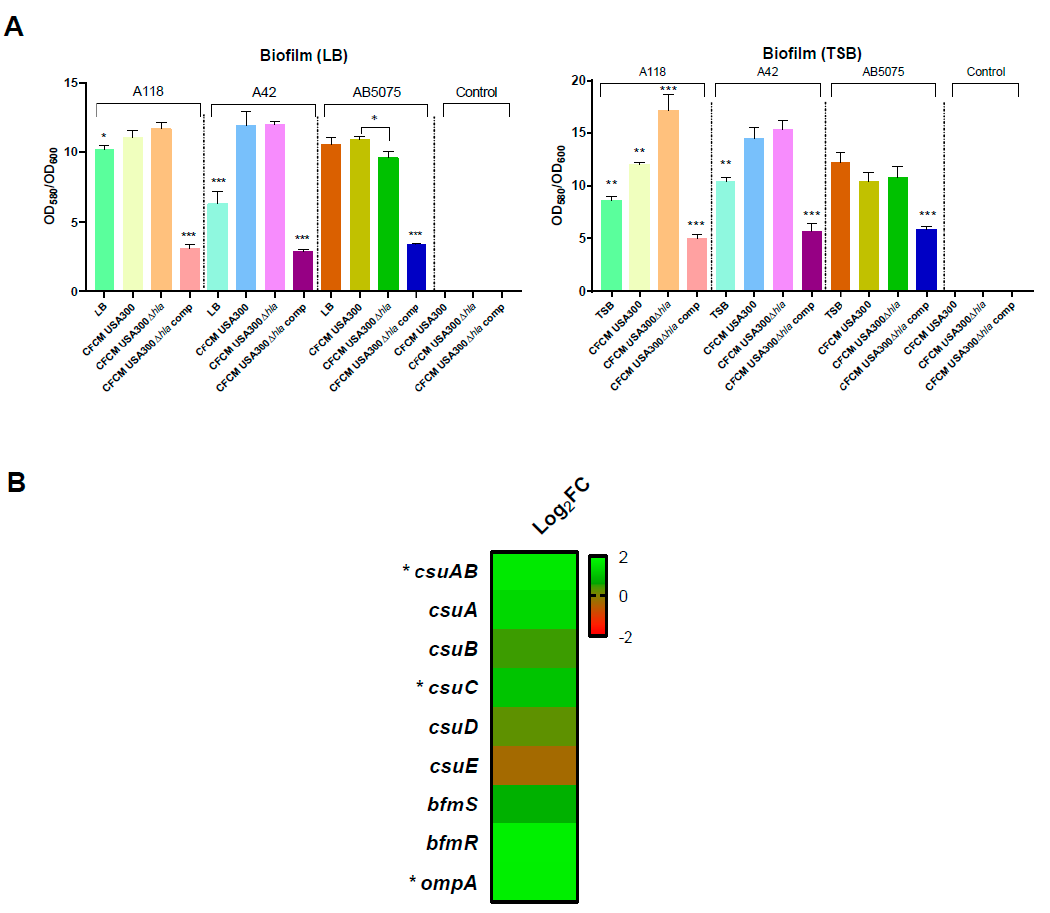
Figure 2. Phenotypic and transcriptomic analysis of associated biofilm formation coding genes. ( A ) Biofilm assays performed with and without CFCM USA300 , CFCM USA300 ∆ hla , or CFCM USA300 ∆ hla comp obtained from LB and TSB represented by OD580/OD600. Experiments were performed in triplicate, with at least three technical replicates per biological replicate. The control condition corresponds to LB or TSB supplemented with CFCM, without inoculating with A. baumannii strains. Statistical analysis for each strain (ANOVA followed by Tukey’s multiple comparison test) was performed using GraphPad Prism (GraphPad software, San Diego, CA, USA), and a p -value < 0.05 was considered significant, one asterisk: p -value < 0.05; two asterisks: p -value < 0.01 and three asterisks: p -value < 0.001. The asterisks observed in the graphs indicate significant differences between the condition with one or more asterisks and the rest of the conditions, except when it is indicated with brackets between these conditions. ( B ) Heatmap showing the differential expression of genes associated with biofilm formation. DEG are indicated with an asterisk (FDR <